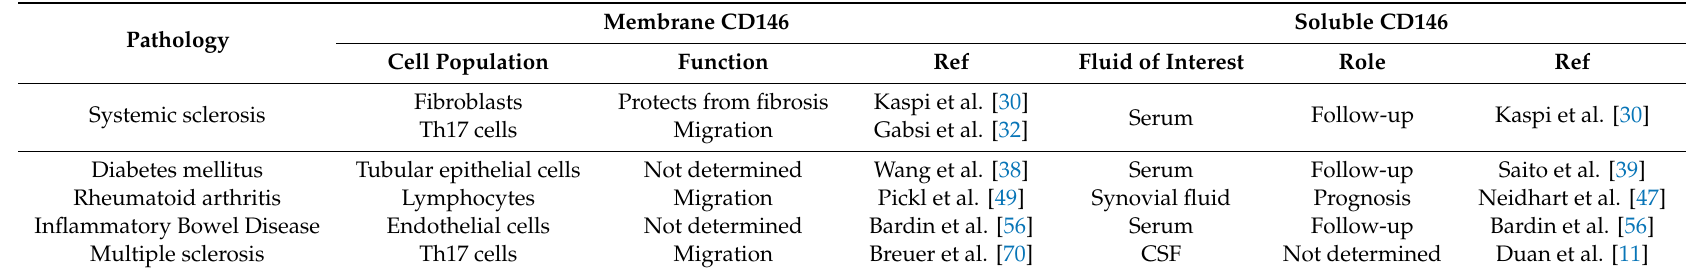
Table 1. CD146 and soluble CD146 in immune